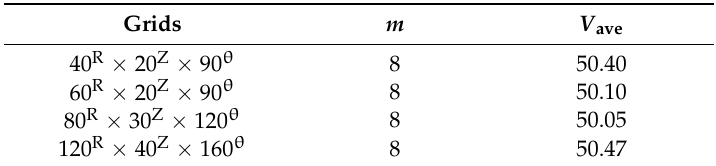
Table 2. Variation of non-dimensional wave number m and velocity fluctuation V ave with grid when Re T = 2000.